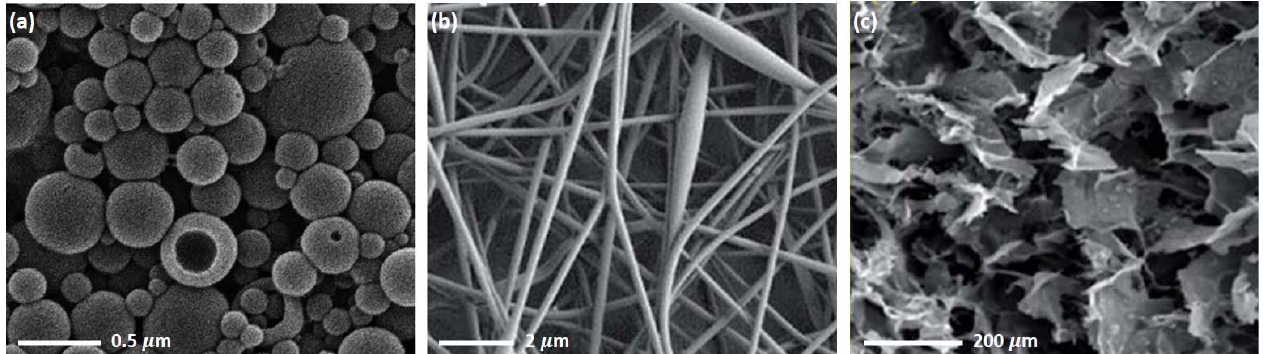
Figure 3. Porous structures in the scanning electron microscopy (SEM) images of ( a ) lignin-based nanocapsules (reproduced from Ref. [20] with permission from the American Chemical Society), ( b ) lignin-based fiber mat (reproduced from Ref. [21] with permission from the Royal Society of Chemistry), and ( c ) lignin-based hydrogel (reproduced from Ref. [22] with permission from the Royal Society of Chemistry).